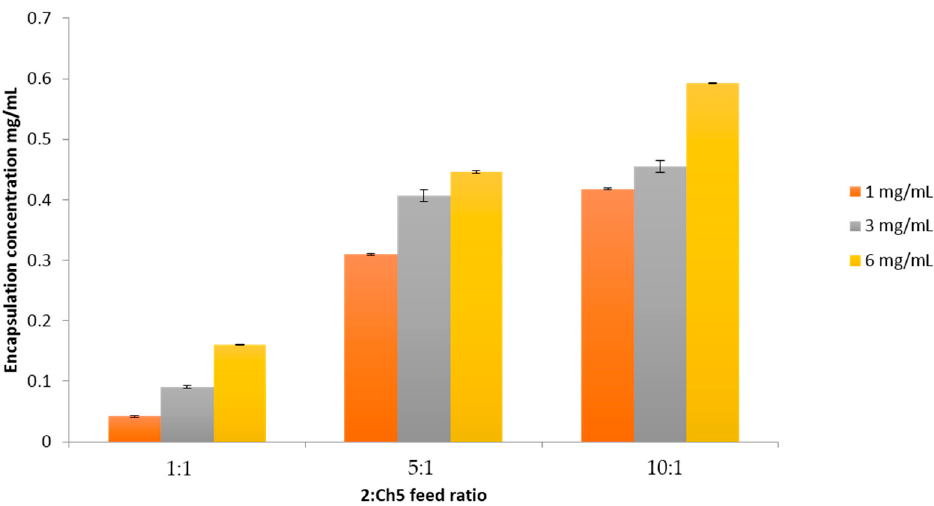
Figure 4. Drug encapsulation at three different feed ratios, 1:1, 5:1, and 10:1, between 2 and the polymer Ch5 . Three initial concentrations of 2 were used: 1, 3, and 6 mg/mL ( n = 3, ±SD).